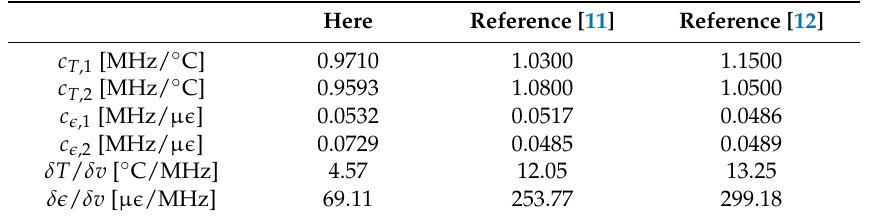
Table 1. Temperature and strain coefficients ( c T ,1 , c T ,2 , c (cid:101) ,1 , and c (cid:101) ,2 ) and error amplification factors ( δ T / δ v and δ(cid:101) / δ v ) (first column) in this study; (second column) Reference [11]; and (third column) Reference [12], as described in the